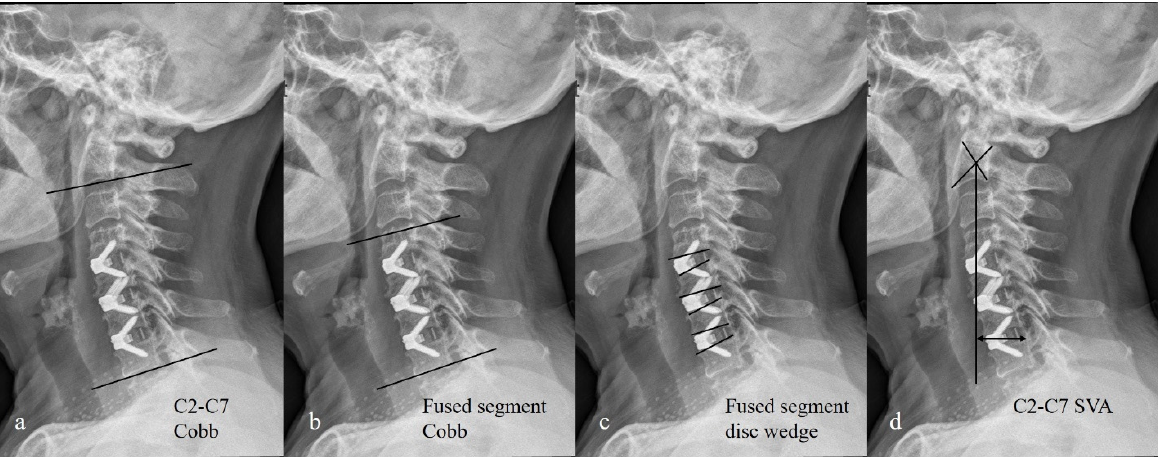
Figure 3. Illustration showing the method of cervical sagittal alignment measurements. ( a ) C2-C7 Cobb angle; ( b ) fused segment Cobb angle (in this case, C4-C7); ( c ) fused segment disc wedge (in this case, C4/5+C5/6+C6/7); ( d ) C2-C7 sagittal vertical axis.